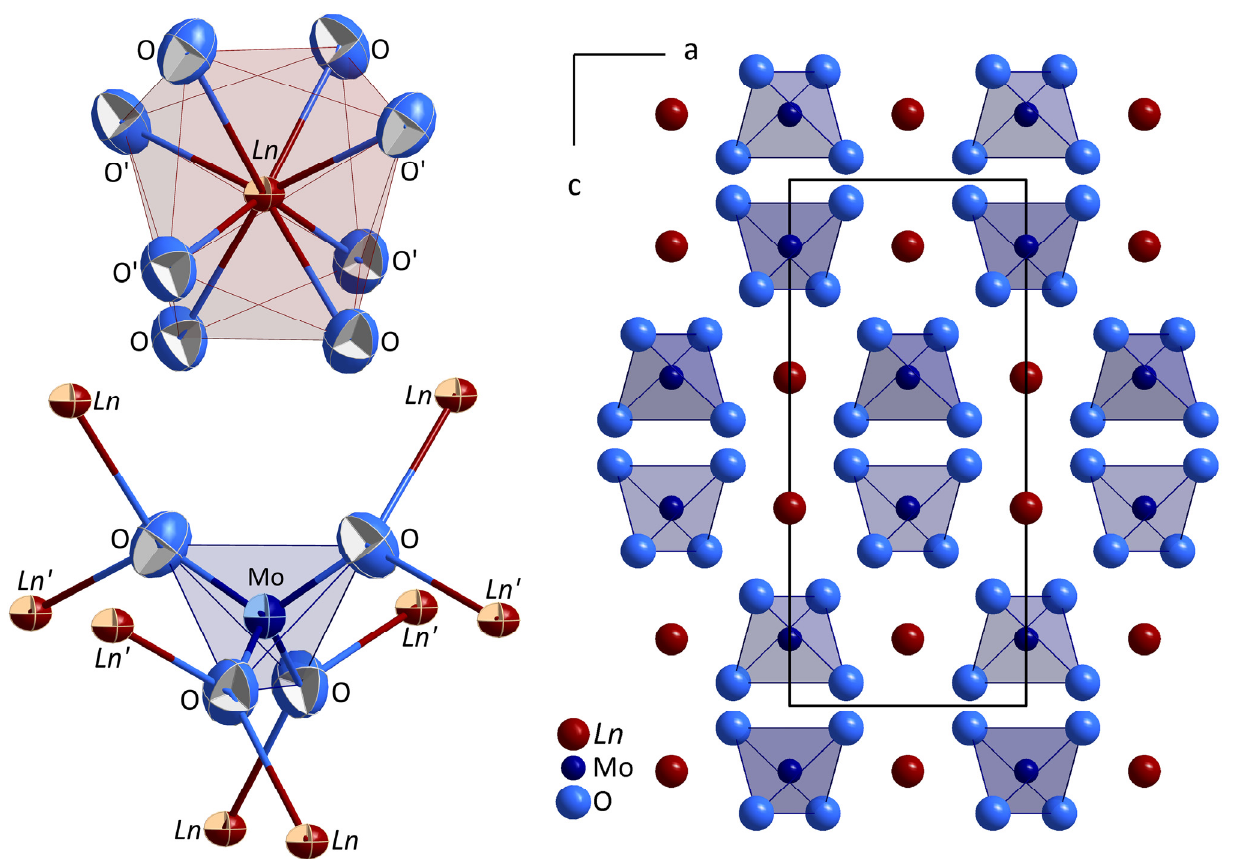
Figure 1. Anionic environment around the crystallographically unique Ln 3+ cations ( left top , thermal ellipsoids at 90% probability), cationic environment around the crystallographically unique [MoO ] 2– tetrahedra ( left bottom , thermal ellipsoids at 90% 4 probability), and view at the unit cell of the defect scheelite -type crystal structure of the Ln [MoO ] series ( Ln = Ce, Pr, Nd, and Sm) along [010] ( right 0.667 4